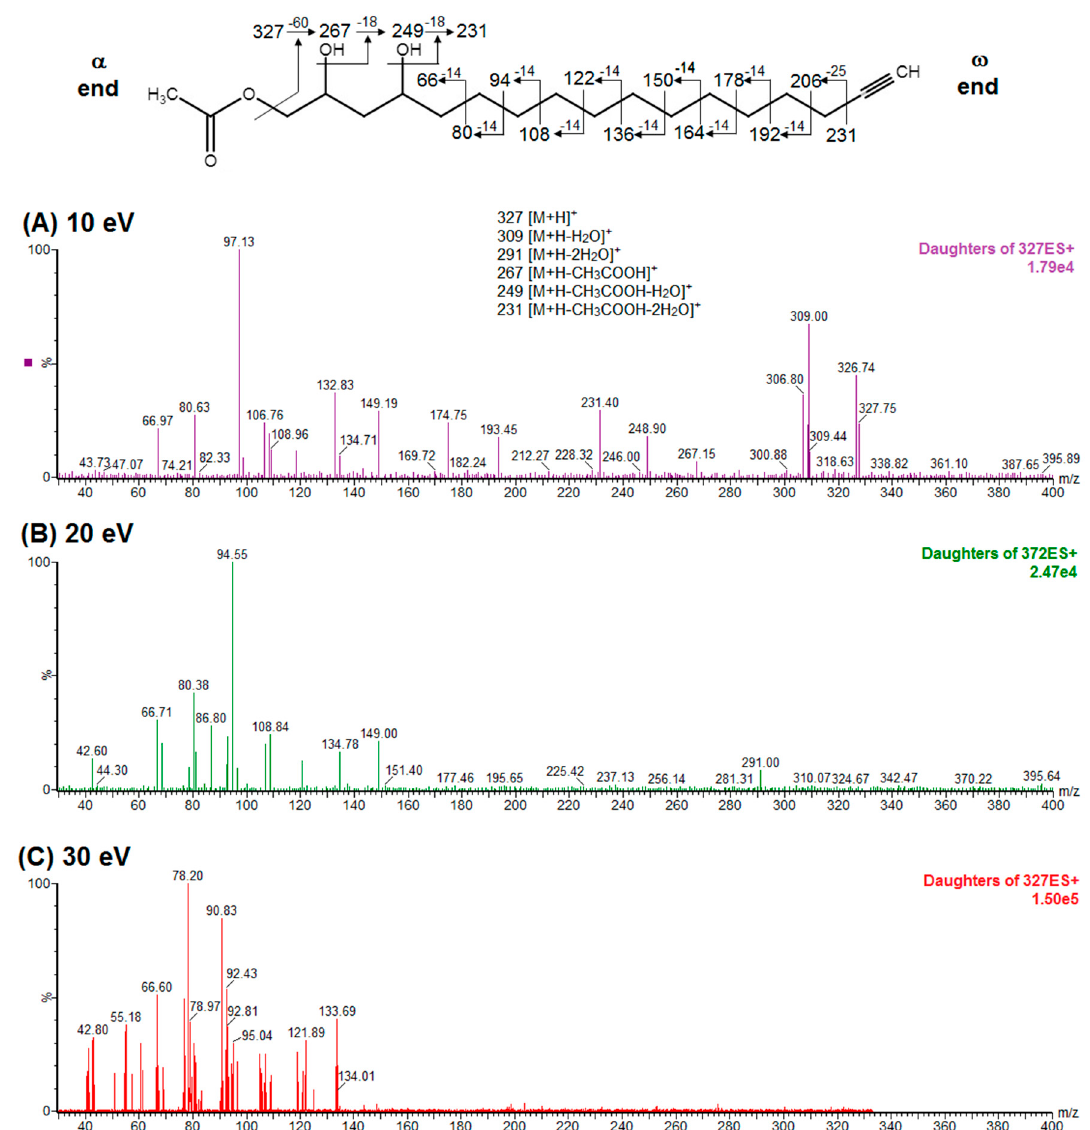
Figure 2. ESI-MS / MS spectra of AcO-avocadyne (labeled as compound 0 in Table 1 and Figure 1) obtained by collision-induced dissociation (CID) of the precursor ion at m / z 327 and the daughter ion at m / z 249. Data shown in panels are for collision energies of ( A ) 10 eV, ( B ) 20 eV, and ( C ) 30 eV. Note: “ α end” refers to the charged side of the molecule that corresponded to oxygenated functional groups, whereas “ ω end” refers to the methyl end.